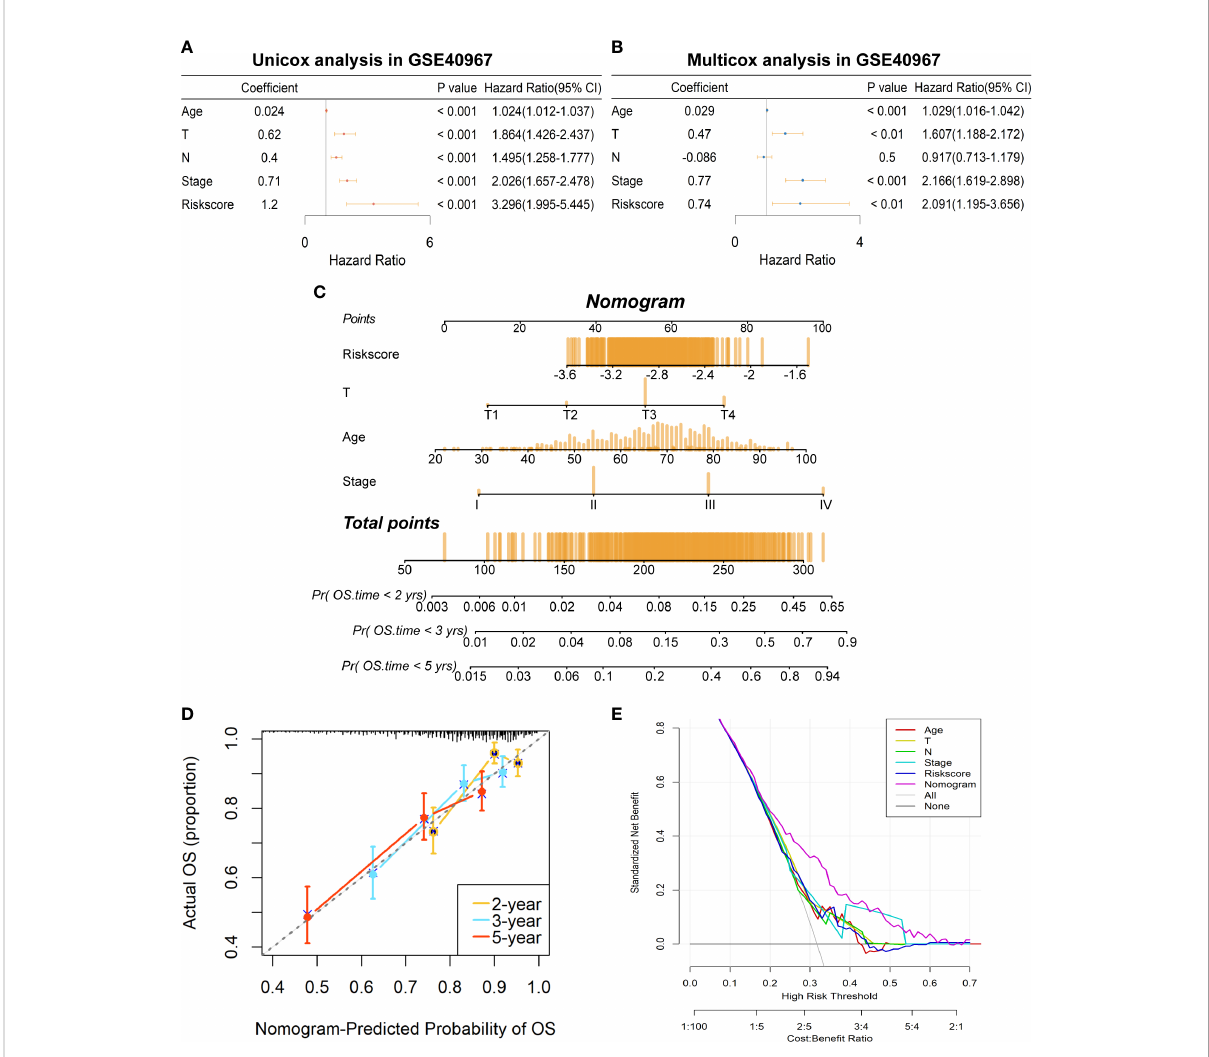
FIGURE 5 Establishment of a prognostic prediction nomogram based on the risk signature in GSE40967 training set. (A) The univariate Cox regression analysis of age, T, N, AJCC stage, and risk score for OS. (B) The multivariate Cox regression analysis of age, T, N, AJCC stage, and risk score for OS. (C) The prognostic nomogram was plotted to predict 2-, 3-, and 5-year survival probability of COAD patients. (D) The calibration plot was used to evaluate the prediction consistency of OS. (E) The DCA to assess clinical utility of the prognostic